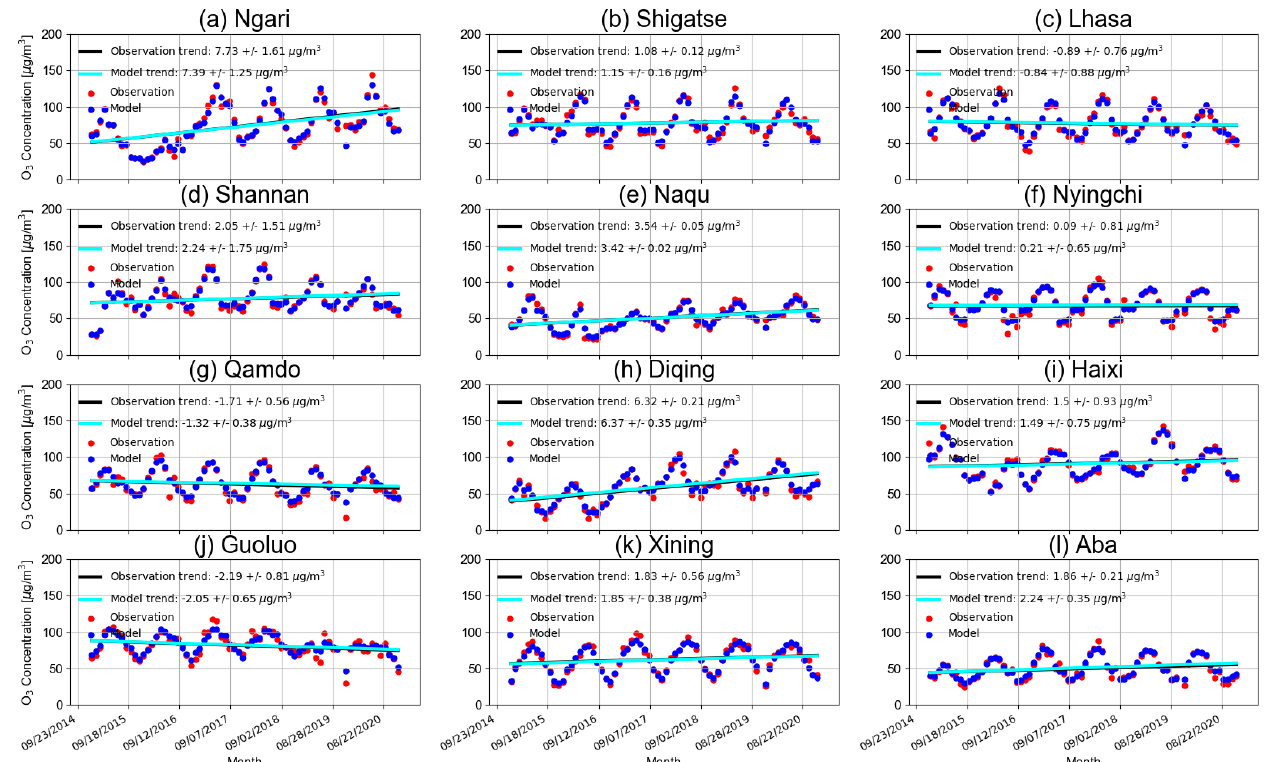
Figure 5. Inter-annual trends of surface ozone levels between 2015 and 2020 in the urban areas over the QTP. Blue dots are the monthly averaged surface ozone measurements. The seasonality and inter-annual variability in each city fitted by using a bootstrap resampling model with a second Fourier series (red dots) plus a linear function (black line) are also